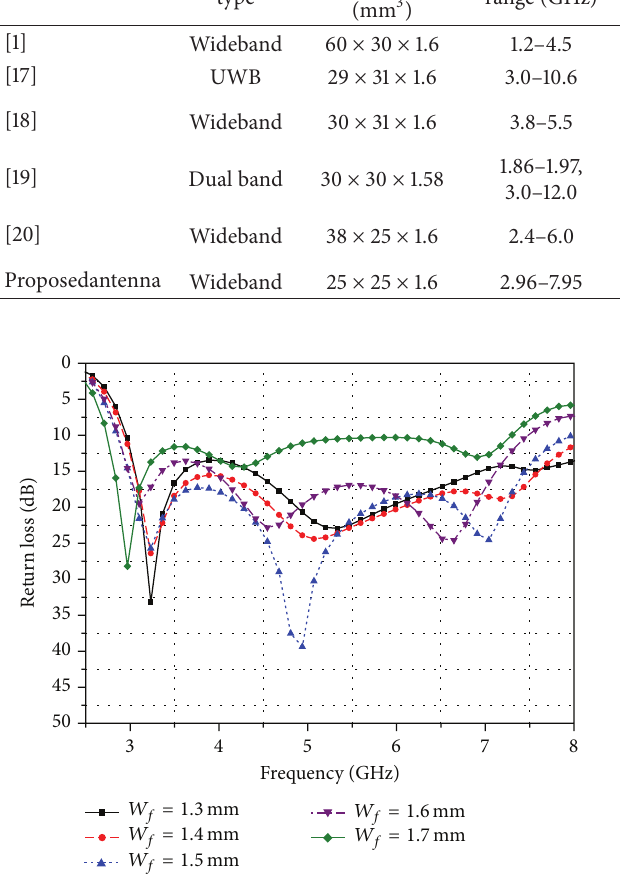
Figure 7: Simulated return loss against frequency for the proposed CPW-fed two-sided T strip wideband microstrip antenna with various values of 𝑊 𝑓 ; other parameters are the same as listed in Table 1.